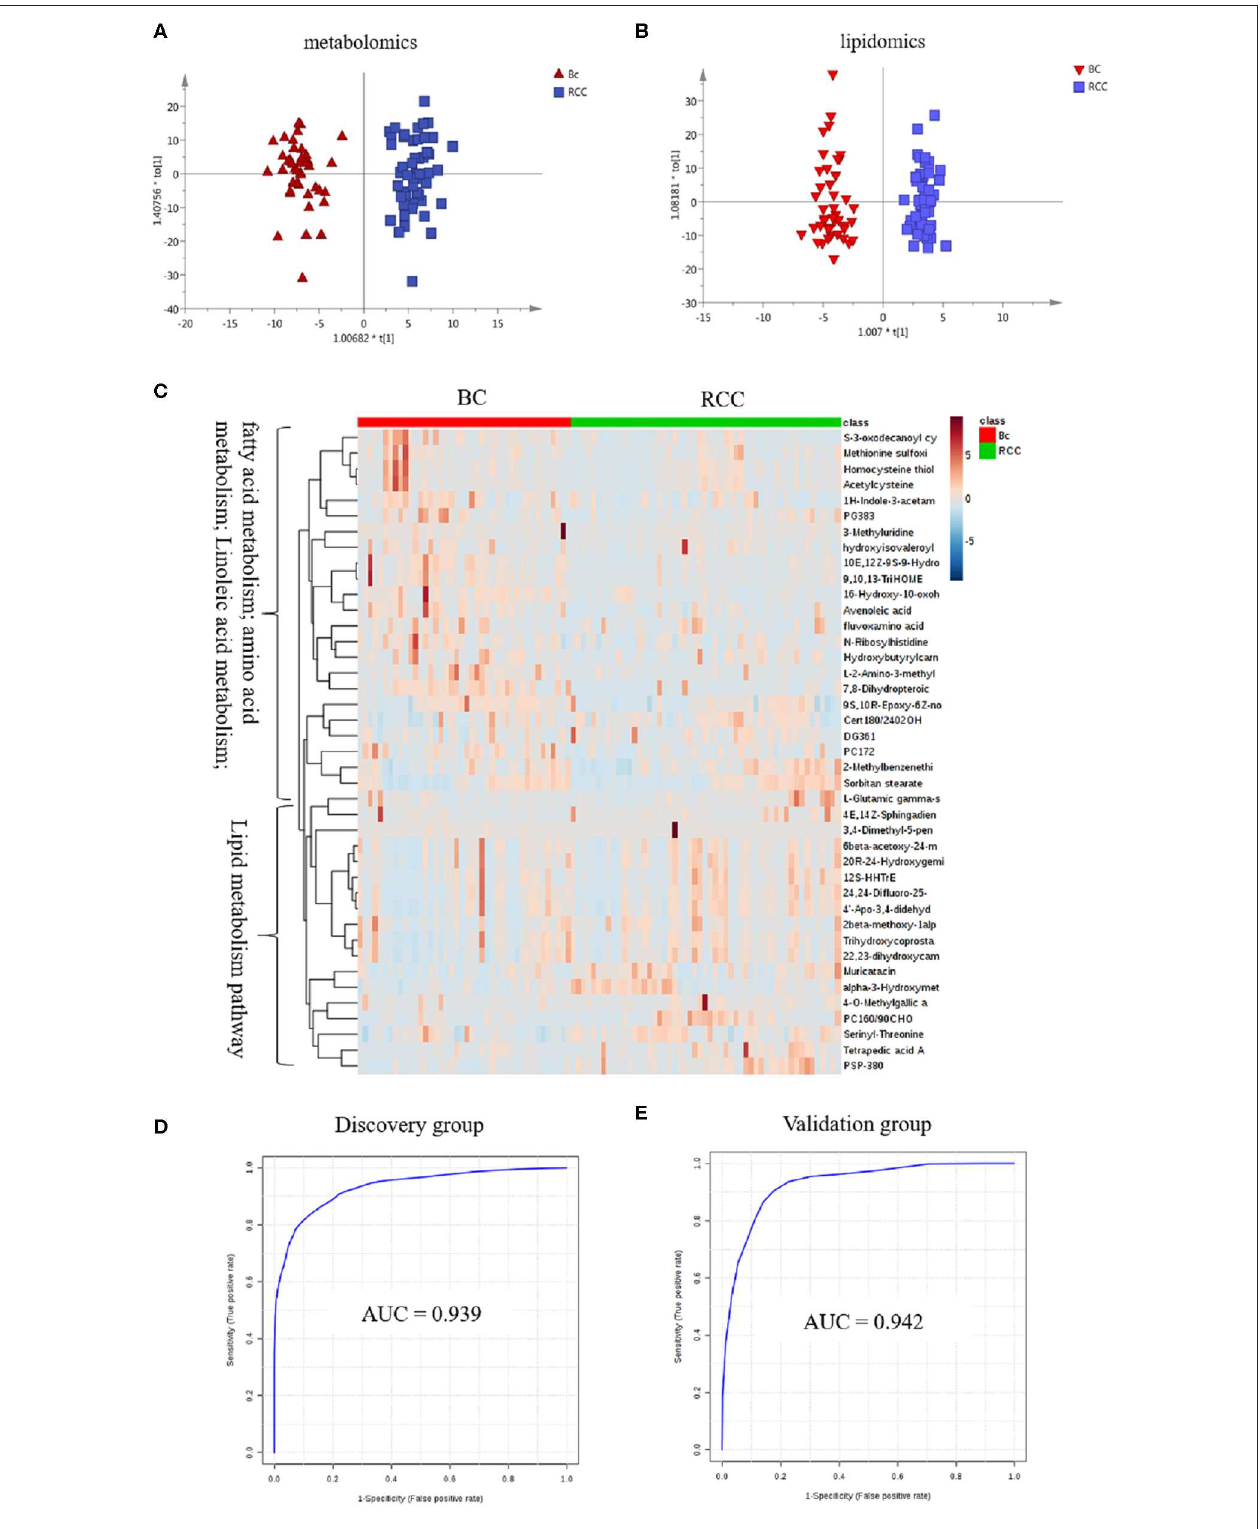
FIGURE 3 | Analysis of plasma metabolomics and lipidomics between 42 BC and 53 RCC. (A) Score plot of OPLS-DA based on plasma metabolic profiling of BC and RCC. (B) Score plot of OPLS-DA based on plasma lipidomic profiling of BC and RCC. (C) Relative intensity of differential metabolites in BC and RCC.